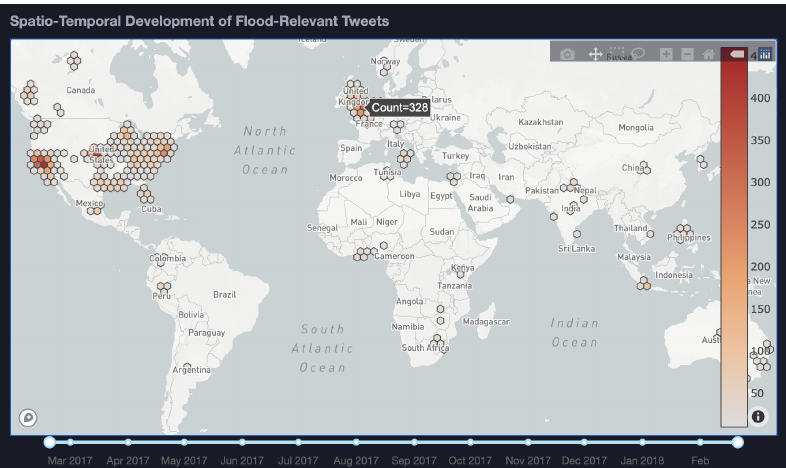
Figure 9. Hexbin map visualising the spatial differences of the number of flood-relevant